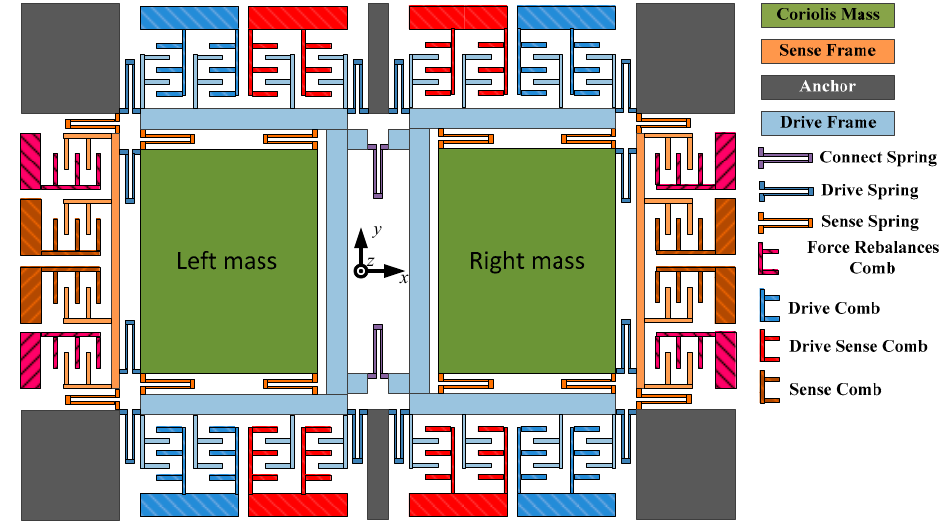
Figure 1. The mechanical structure of dual-mass microelectromechanical systems (MEMS) gyroscopes.